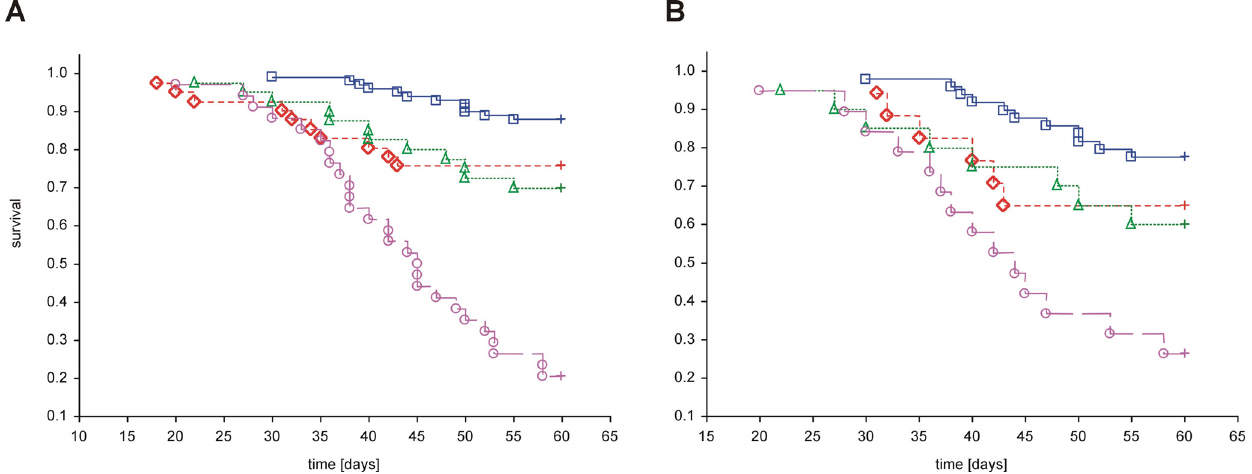
Figure 4. Kaplan-Meier curves of cumulative survival in animals treated intraperitoneally with PAMAM dendrimers G2, G3 and G4. The step function of the estimated cumulative fraction of surviving animals are given for pooled non-diabetic and streptozotocin-diabetic animals ( A ) or STZ-diabetic animals ( B ) treated with vehicle or with various PAMAM dendrimers. Complete observations are marked with squares, diamonds, triangles and circles for vehicle, PAMAM G2, G4 and G3, respectively; censorships are marked by “+”. The significance of differences between survival curves (log-rank Peto test) for the combined strata (non-diabetic, diabetic), was p < 0.0001; p < 0.0001 for the chi 2 test for the trend: veh < G2 = G4 <